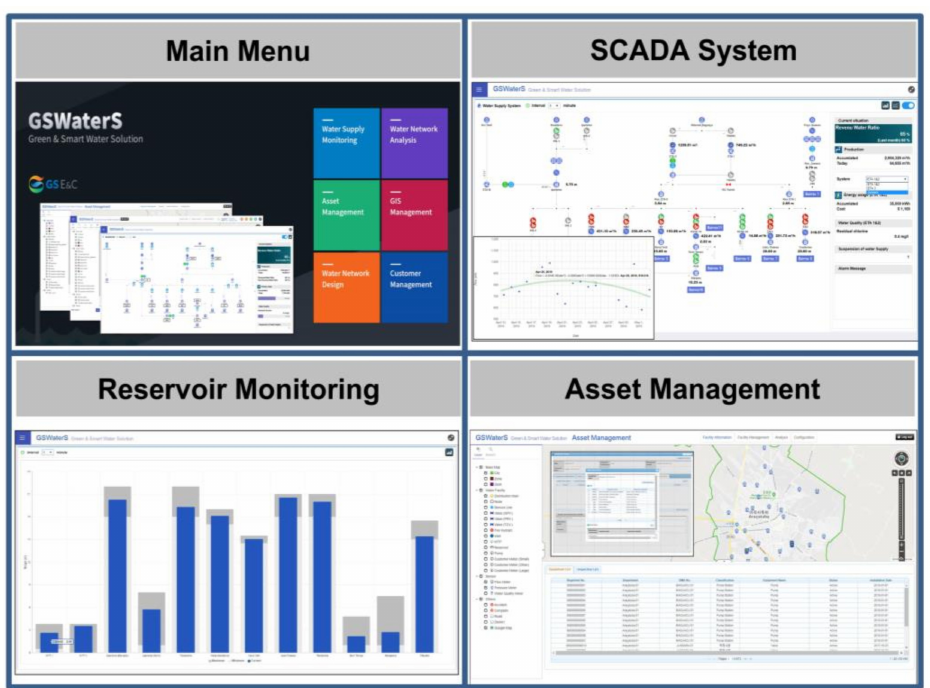
Figure 4. Customized graphical user interface for